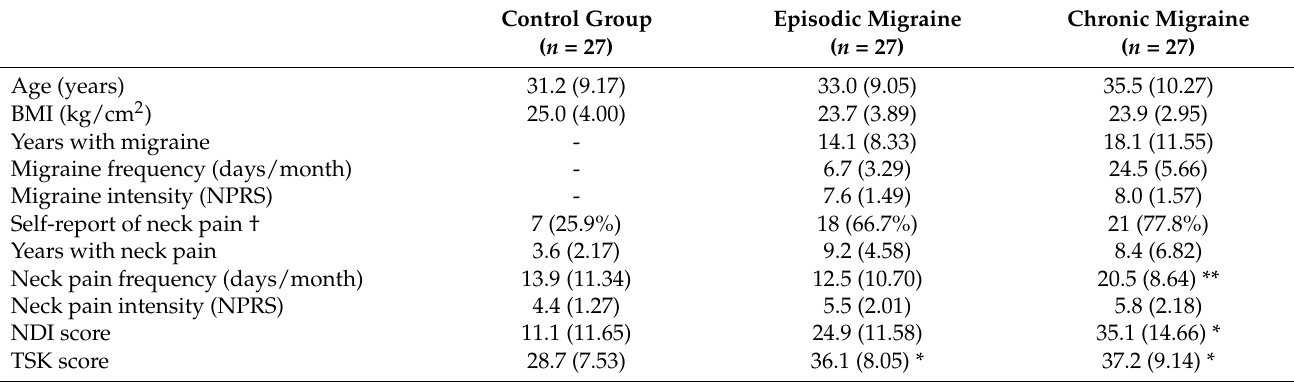
Table 1. Mean, standard deviation, and frequency of sample sociodemographic characteristics and clinical